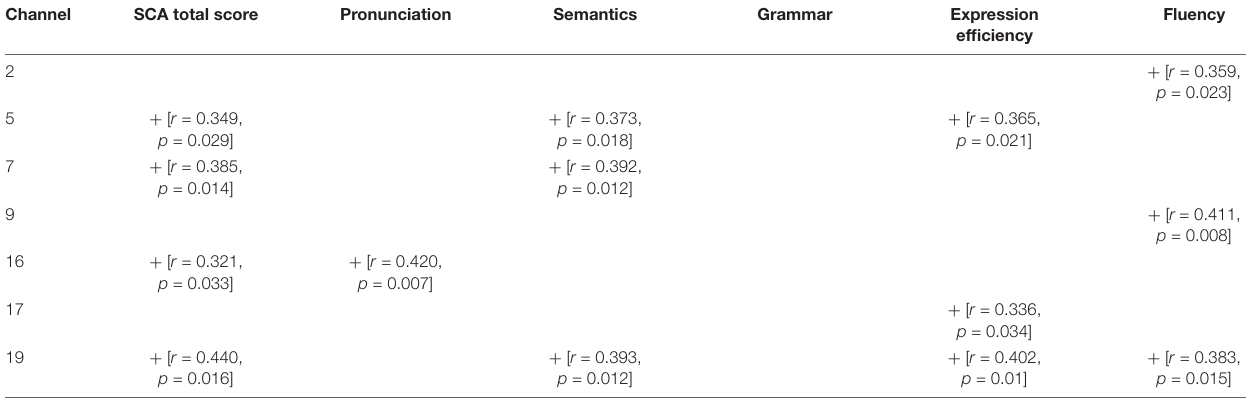
TABLE 4 | Correlation between neural activation to strong-prosodic (SP) and evaluation scores of speech communication ability (SCA) test. Channel SCA total score